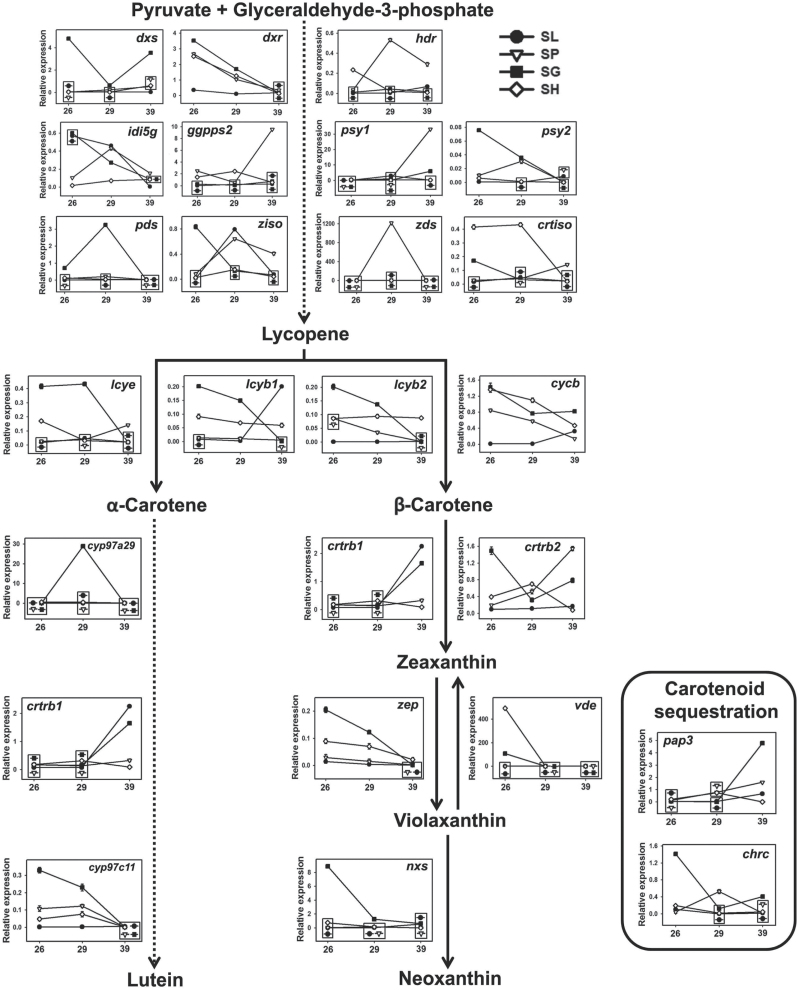
Relative expression of genes mediating carotenoid biosynthesis and sequestration in tomato and wild species. The relative transcript levels were measured from 26, 29 and 39 dpa fruits after normalization with β-actin and ubiquitin (Table S7 shows means±SE (n=3) along with corresponding P-values). Dotted arrows indicate multiple steps in the carotenoid biosynthesis pathway. The genes mediating carotenoid sequestration are enclosed in a rectangle. The overlapping symbols are enclosed in a box. Error bars smaller than the symbol are masked underneath. chrc, chromoplast-specific carotenoid associated protein; crtiso, carotenoid isomerase; crtrb1, β-carotene hydroxylase 1; crtrb2, β-carotene hydroxylase 2; cycb, chromoplast-specific lycopene β-cyclase; cyp97a29, cytochrome P450 carotenoid β-hydroxylase A29; cyp97c11, cytochrome P450 carotenoid ε-hydroxylase C11; dxr, deoxy-xylulose 5-phosphate reductase; dxs, deoxy-xylulose 5-phosphate synthase; ggpps2, geranylgeranyl diphosphate synthase 2; hdr, 4-hydroxy-3-methylbut-2-enyl diphosphate reductase; idi5g, isopentenyl diphosphate isomerase 5g; lcyb1, lycopene β-cyclase 1; lcyb2, lycopene β-cyclase 2; lcye, lycopene ε-cyclase; pds, phytoene desaturase; nxs, neoxanthin synthase; pap3, plastid lipid-associated protein 3; psy1, phytoene synthase 1; psy2, phytoene synthase 2; vde, violoxanthin deepoxidase; zds, ζ-carotene desaturase; zep, zeaxanthin epoxidase; ziso, ζ-carotene isomerase.